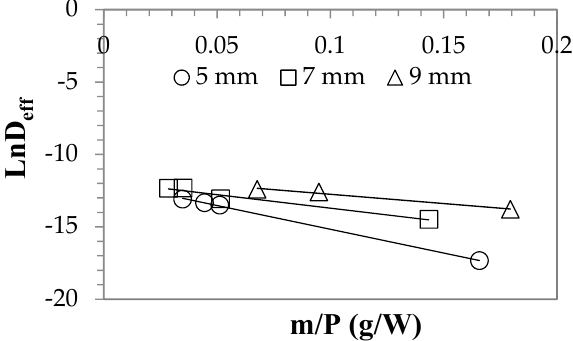
Figure 3. Microwave powers effect on effective diffusion coefficient. Table 2. The diffusion coefficients and activation energy values of the persimmon slices at different powers.